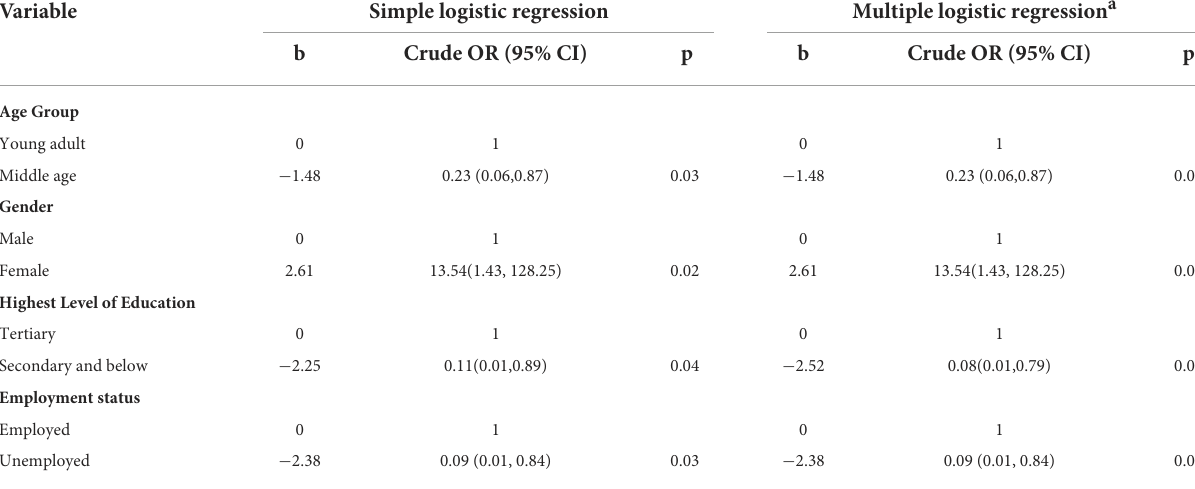
TABLE 6 Factors associated with the use of positive reframing as a coping strategy by the simple and multiple logistic regression model.